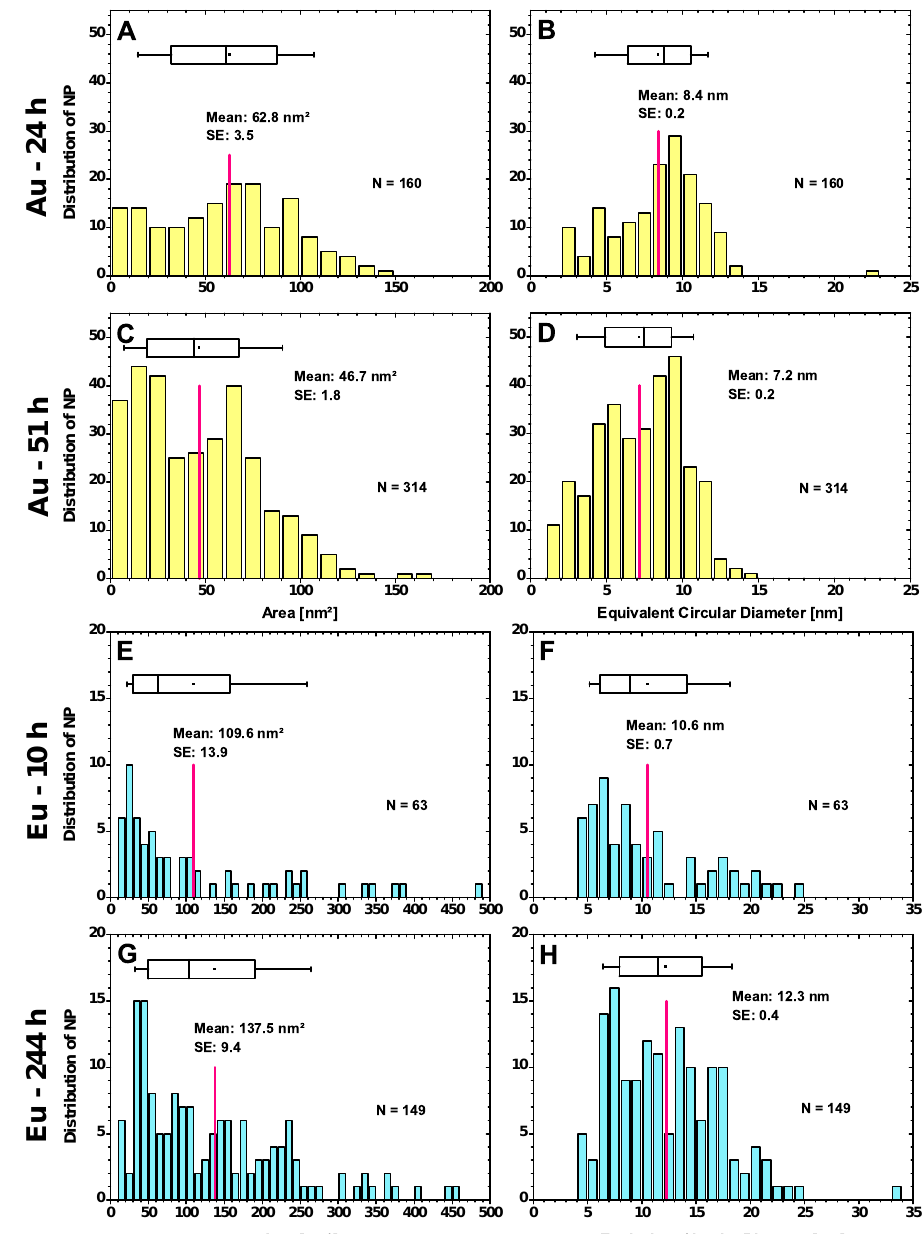
Figure 3. HR-PSD for Au-NPs after 24 h ( A , B ) and 51 h ( C , D ) and for Eu-NPs after 10 h ( E , F ) and 244 h ( G , H ) with the mean value and standard error (SE). The number of particles N counted in total for the same cell volume and the average area or particle diameter (red lines) are indicated in the plots. The ECDs are calculated from the areas assuming round particles. Again, the boxplots show the 25% and 75% percentiles, with the whiskers at 10% and